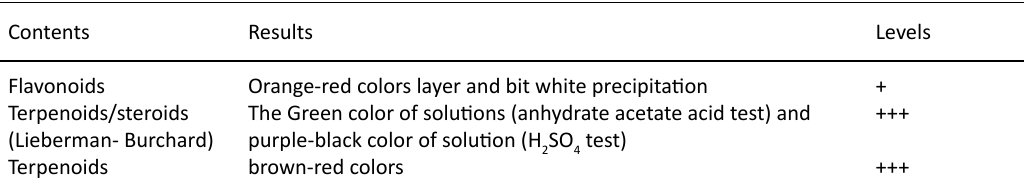
Table 1. Levels of Phytochemical: flavonoids, terpenoids, and steroids in the stem bark of the Datuan plant species (FvWM) Contents Results Levels Flavonoids Terpenoids/steroids